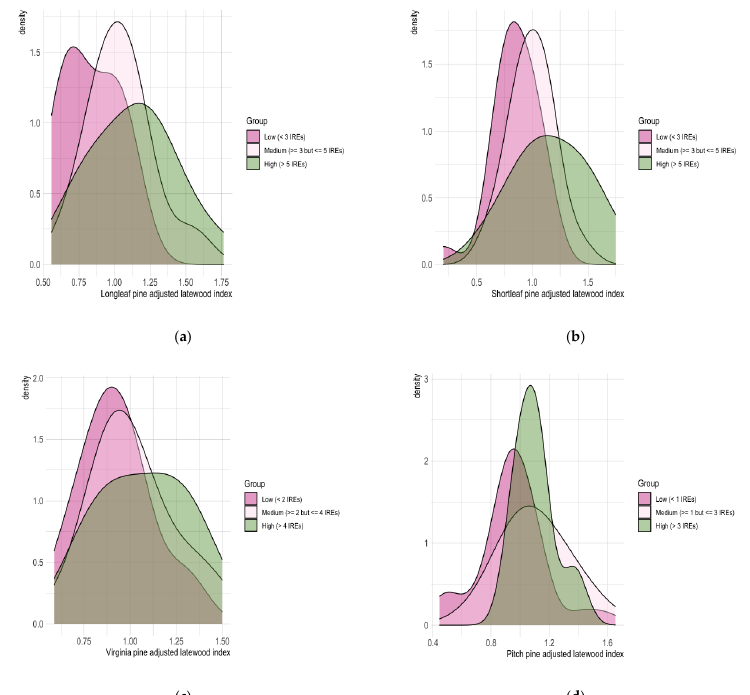
Figure 4. Adjusted latewood ( x -axis) distribution density ( y -axis) during low-, medium-, and high- IRE frequency summers for ( a ) longleaf pine, ( b ) shortleaf pine, ( c ) Virginia pine, and ( d ) pitch pine. The three pine species growing in the Uwharrie Mountains ( a – c ) have significant growth reductions during low-IRE frequency years when compared to high-IRE frequency years displayed by a signif- icant distribution density shift. Longleaf pine ( a ) and pitch pine ( d ) have significant growth reduc- tions during medium-IRE frequency years when compared to high-IRE frequency years.